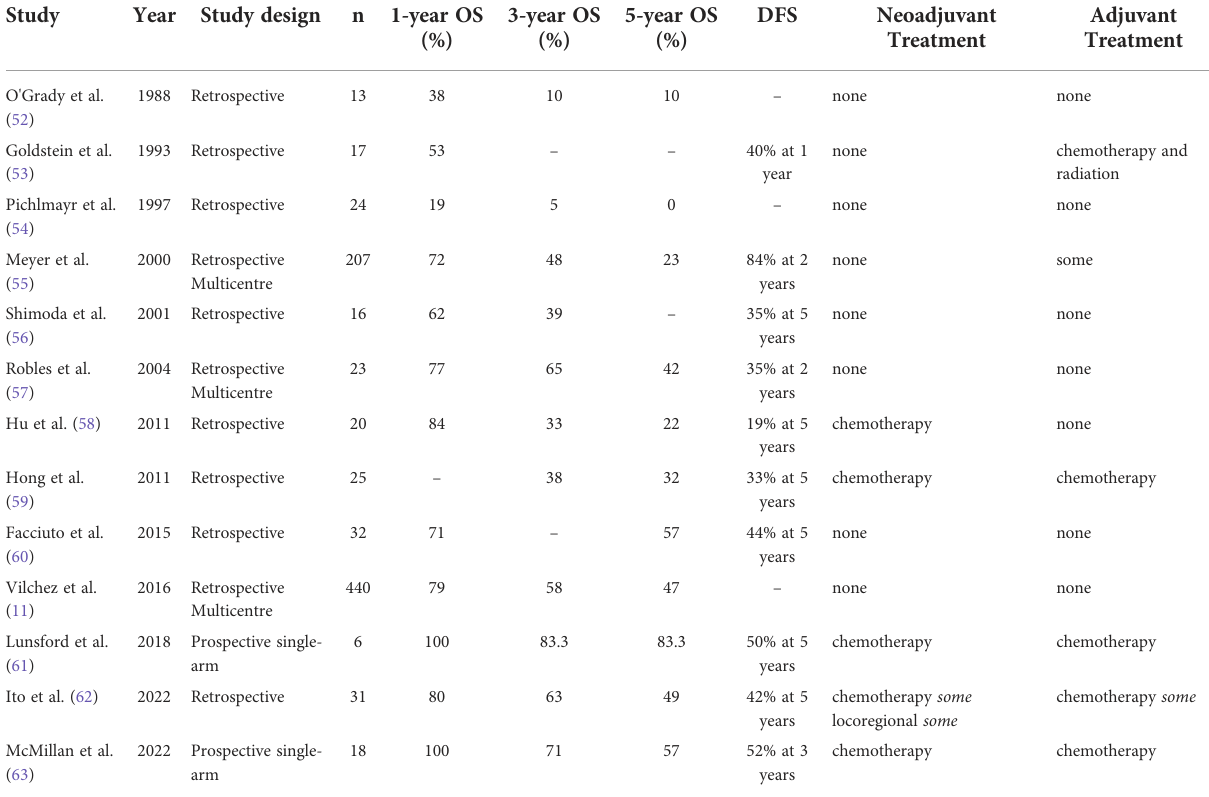
TABLE 2 Case series on liver transplantation for pre-operatively discovered intrahepatic